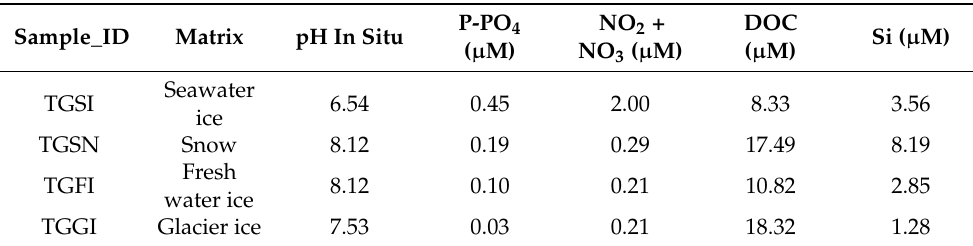
Figure A10. The distribution of grain size composition of bottom sediments in Templefjord in front of the river (TG-1), near the glacier (TF-4), in permafrost (TG-8), and in riverine sediments (R) (June 2017). Table A4. Data on nutrient content in seawater ice (TGSI), snow (TGSN), freshwater ice (TGFI), and glacier ice (TGGI) in Templefjord (June 2017).